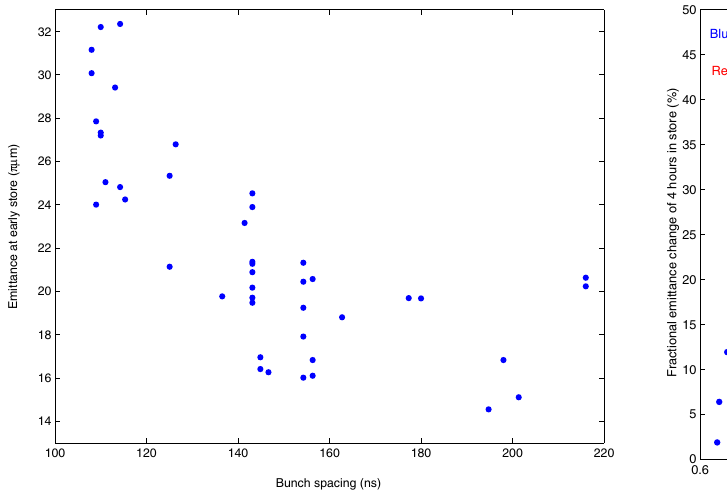
FIG. 8. (Color) The fractional increase of the beam emittance during the first 4 hours of the beam store for runs 2005 and 2006. In (a) it is plotted against the bunch intensity, and in (b) it is plotted against the beam-beam parameter.